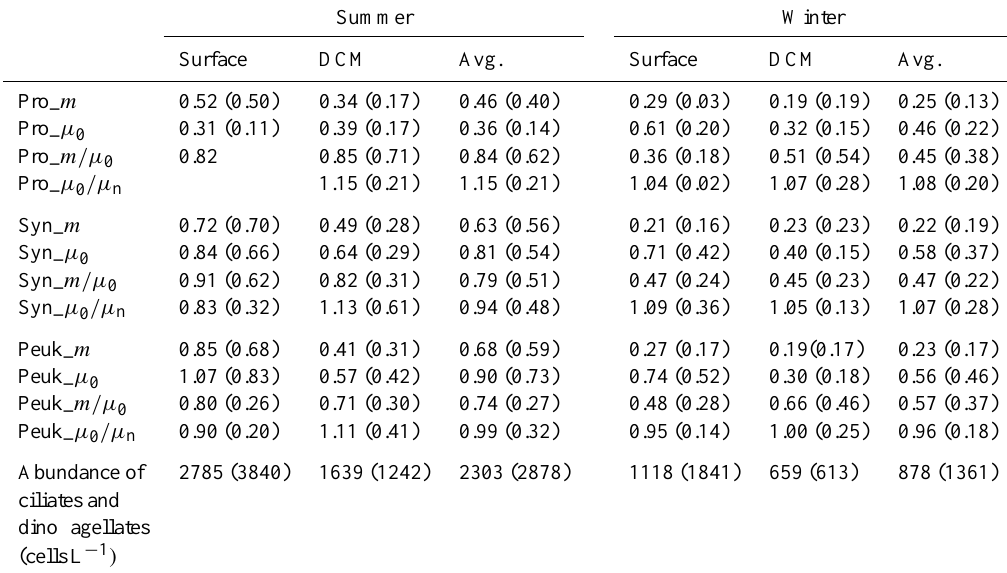
Table 4. Comparison of m , µ , m/µ , and µ 0 /µ n of three populations at the surface and in DCM layers in summer and